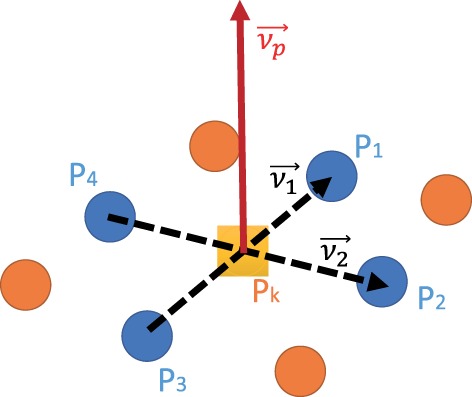
An illustration of normal vector v→p of point Pk.